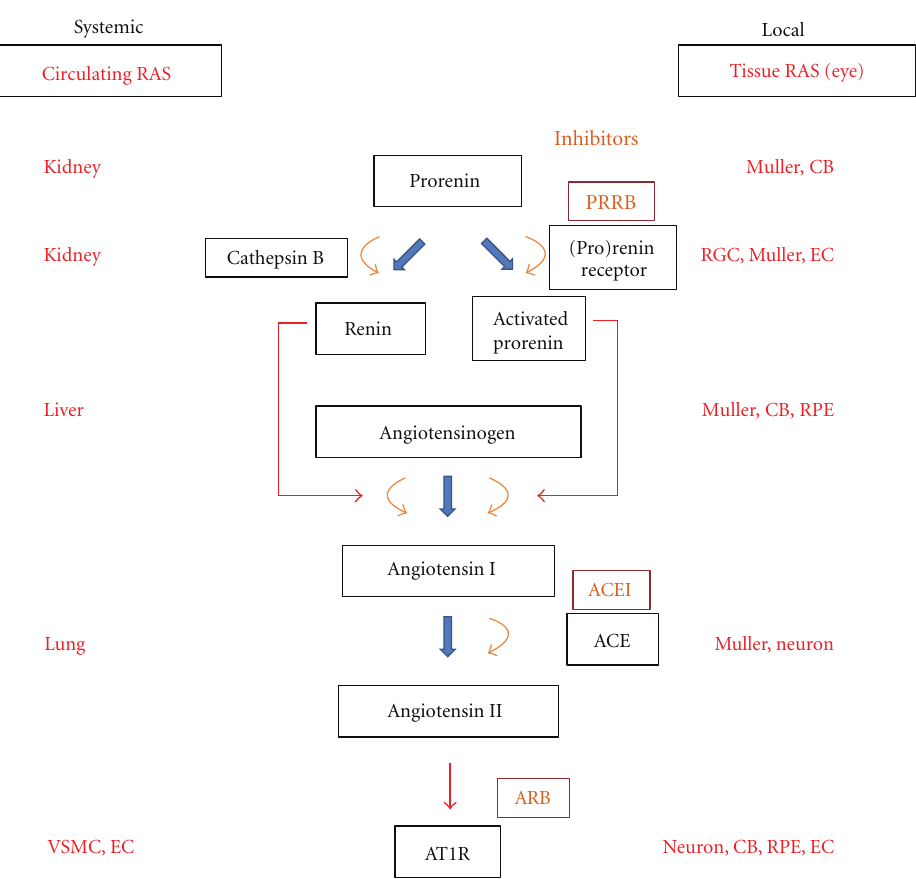
Figure 1: Circulating and tissue renin-angiotensin system (RAS). VSMC: vascular smooth muscle cell, EC: endothelial cell, PRRB: (pro)renin receptor blockers, ACEI: angiotensin-converting enzyme inhibitors, ARB: angiotensin II type 1 receptor blockers, AT1R: angiotensin II type 1 receptor, CB: ciliary body, RPE: retinal pigment